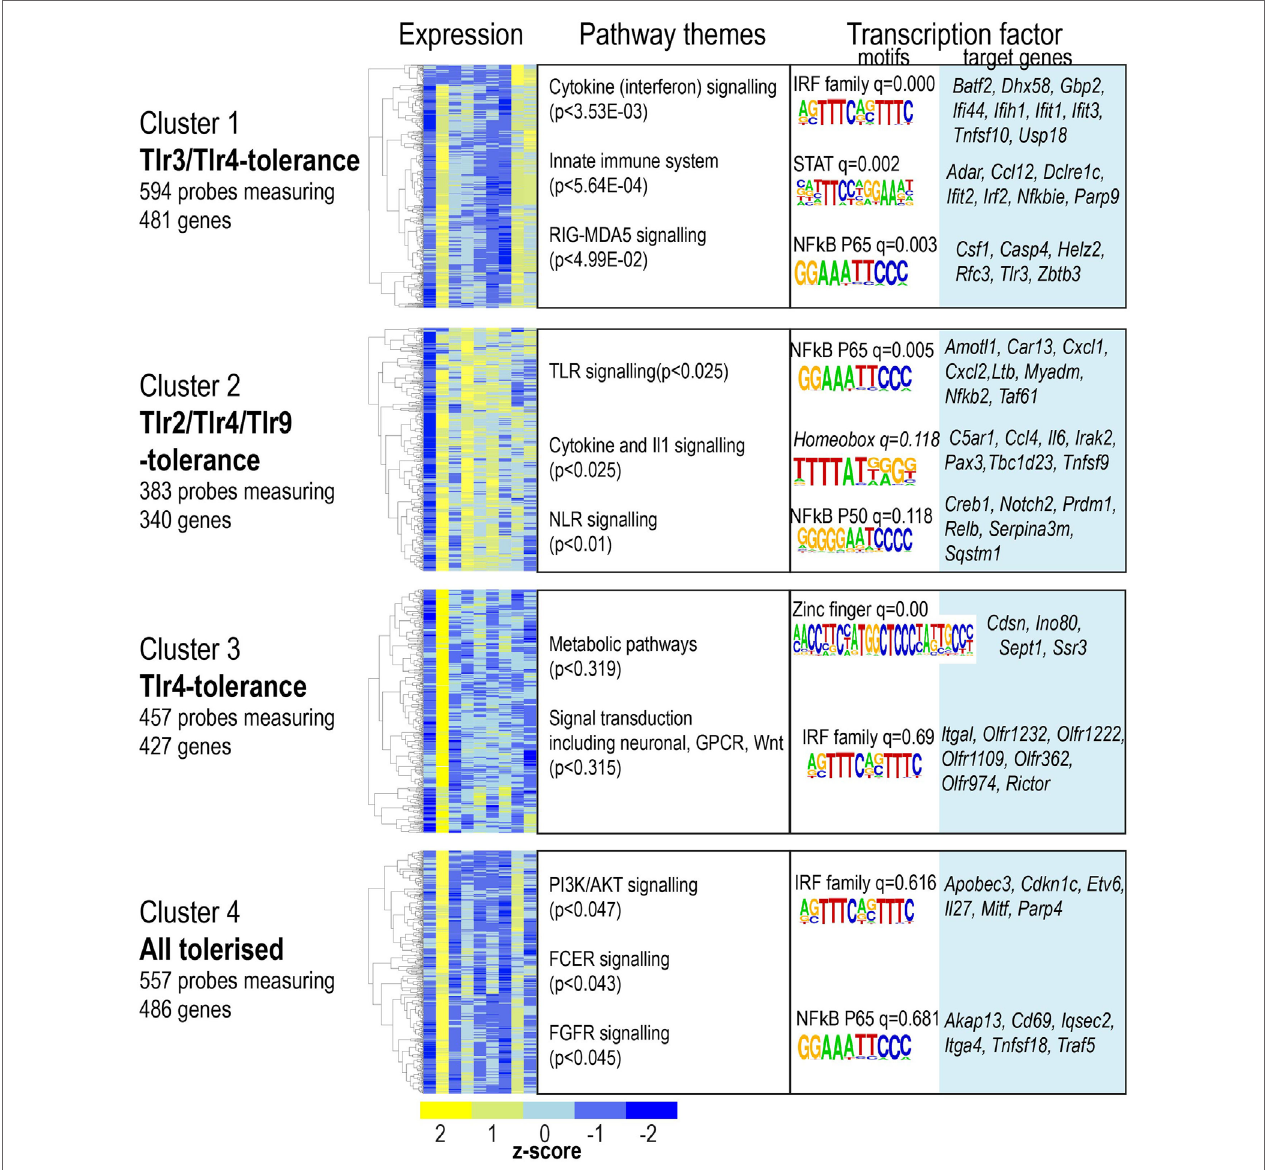
FigUre 4 | Four clusters of gene expression reveal toll-like receptor-specific patterns of tolerance. Microarray probes showing tolerance in at least one infection were grouped using partitioning around medoids-clustering. Heat maps for each cluster. Color indicates row z -score of mean log 2 expression. Columns (L–R) naïve, lipopolysaccharide acute, and restimulation; CpG acute, restimulation; Pam3csk4 acute, restimulation; Poly(I:C) acute and restimulation. Pearson correlation of z scores shown in rows. Significantly enriched pathways, grouped thematically. Maximum adjusted p -value for all pathways significantly enriched in that theme is shown. Transcription factor binding motifs enriched in each cluster. Motif logos and adjusted q -values are representative for each transcription factor family. Full motif enrichment results are available at